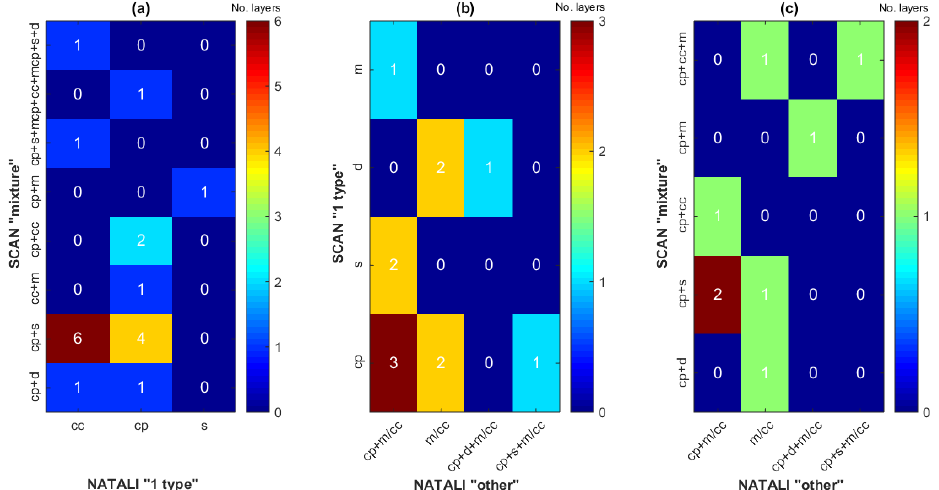
Figure 10. Comparison between the cases classified by (a) SCAN as mixture and as 1 type by NATALI, (b) SCAN as 1 type and as other by NATALI, and (c) SCAN as mixture and as other by